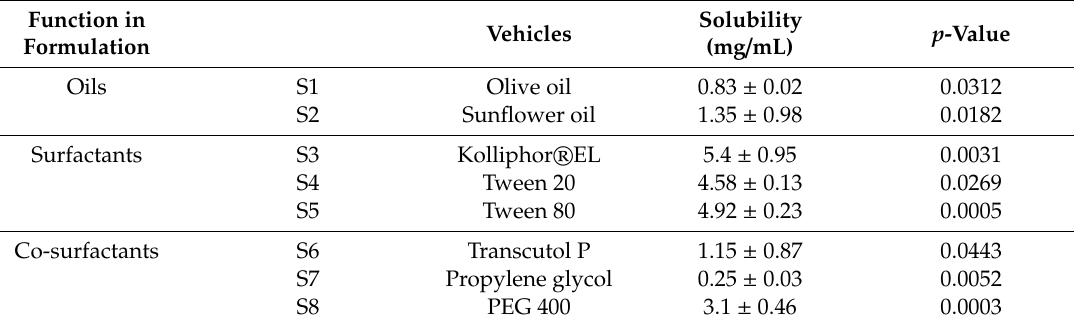
Table 1. Solubility of KY19382 in selected